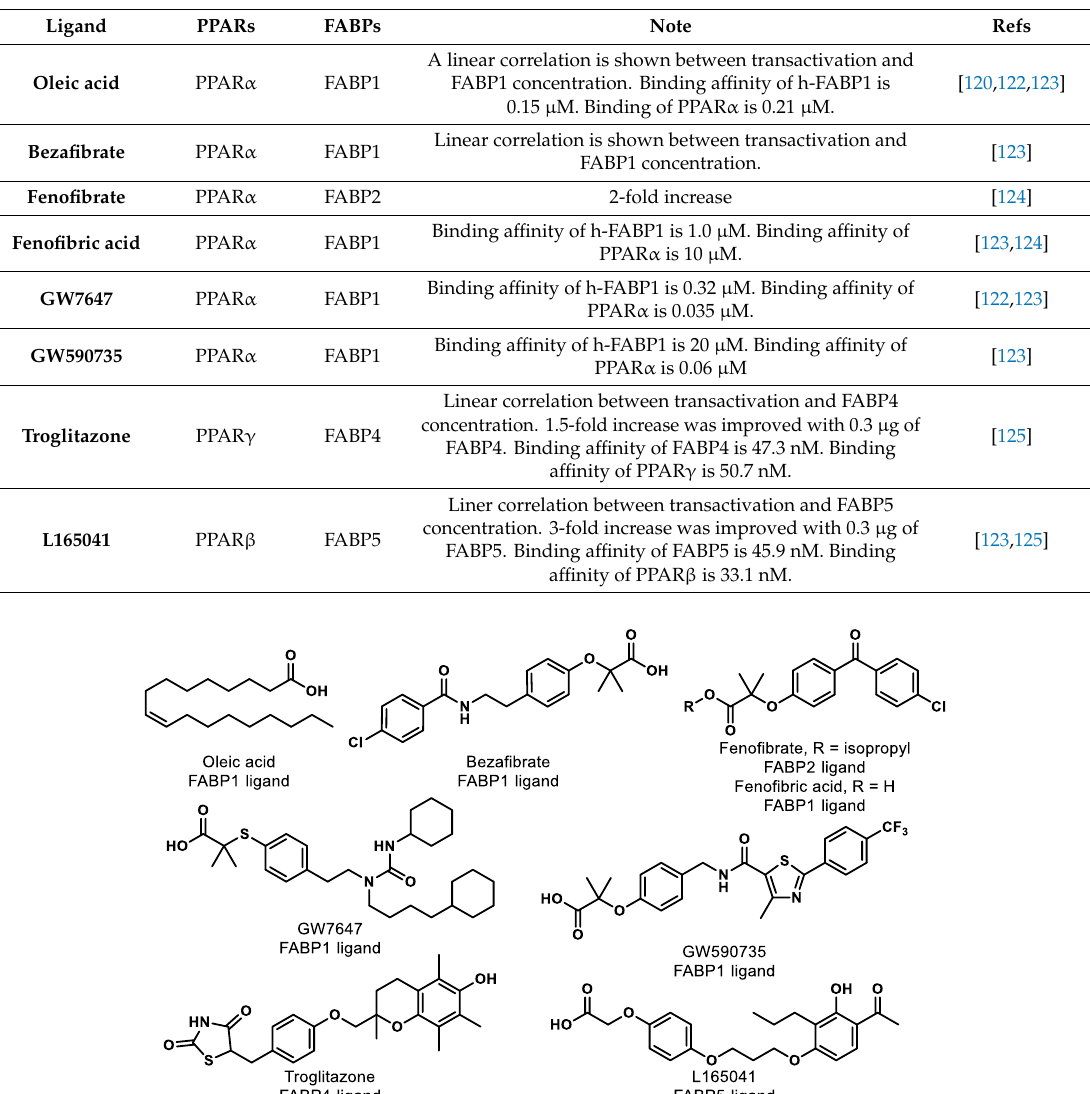
Table 2. PPAR ligands interact with FABPs. Table 2 . PPAR ligands interact with FABPs .